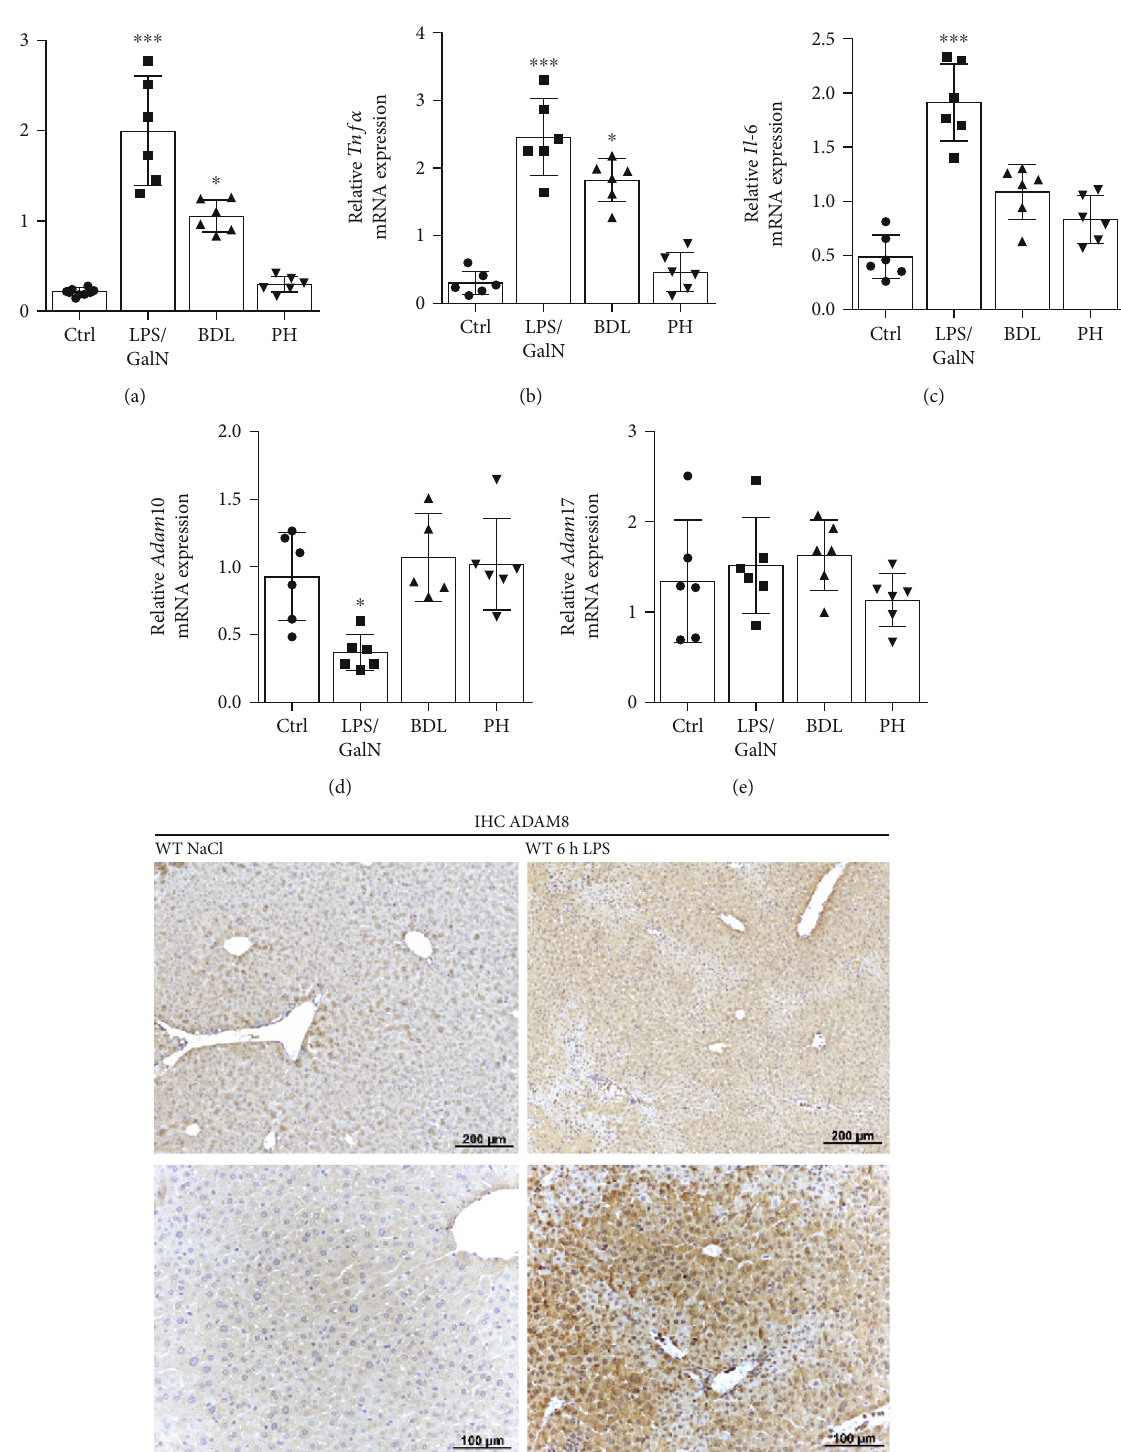
Figure 1: Upregulation of ADAM8 mRNA expression in di ff erent murine models of liver injury. (a – e) Liver tissue was obtained from control mice (Ctrl) or mice with di ff erent types of liver injury induced by either treatment with LPS/GalN for 6h, by bile duct ligation (BDL) (3 weeks), or by partial hepatectomy (PH) (48 h). The mRNA expression of Adam8 (a), TNF- α (b), IL-6 (c), Adam10 (d), and Adam17 (e) in these livers was determined by qPCR. The mRNA expression was normalised to the average of two reference genes: Rps29 and Gapdh . Data are shown as the mean ± SD . Six mice were used in each group. Di ff erences to the control are indicated as asterisks ( ∗ p < 0 : 05 , ∗∗ p < 0 : 01 , and ∗∗∗ p < 0 : 001 ). (f) Immunohistochemistry analysis of liver sections from mice treated with or without LPS for 6h with a polyclonal antibody against ADAM8. Representative tissue stainings for two di ff erent mice per group ( n = 3 ) are